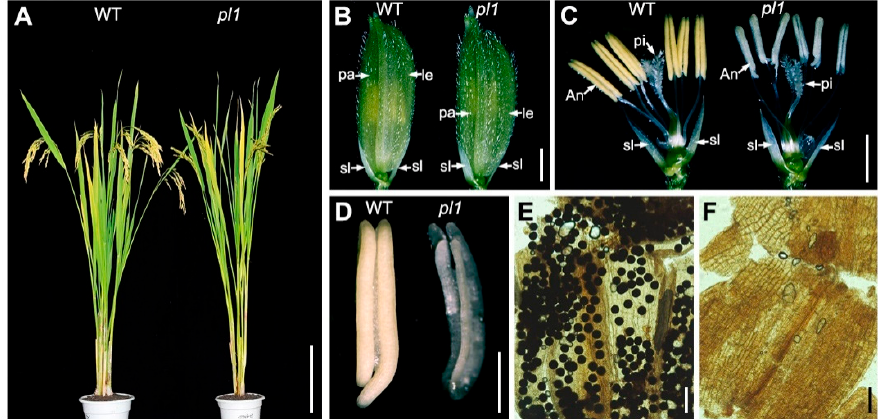
Figure 1. Phenotypic comparison between the WT and pl1 mutant. ( A ) Plant phenotype of the WT and pl1 mutant at grain-filling stage. ( B ) Spikelet of the WT and pl1 mutant at heading stage. le, lemma; pa, palea. ( C ) Spikelet of the WT and pl1 mutant after removing of the lemma and palea. An, anther; pi, pistil; sl, sterile lemma. ( D ) Anther of the WT and pl1 mutant. ( E ) I2 -KI staining of WT pollen grains at maturing stage. ( F ) I2 -KI staining of pl1 pollen grains at maturing stage. Bars = 20 cm